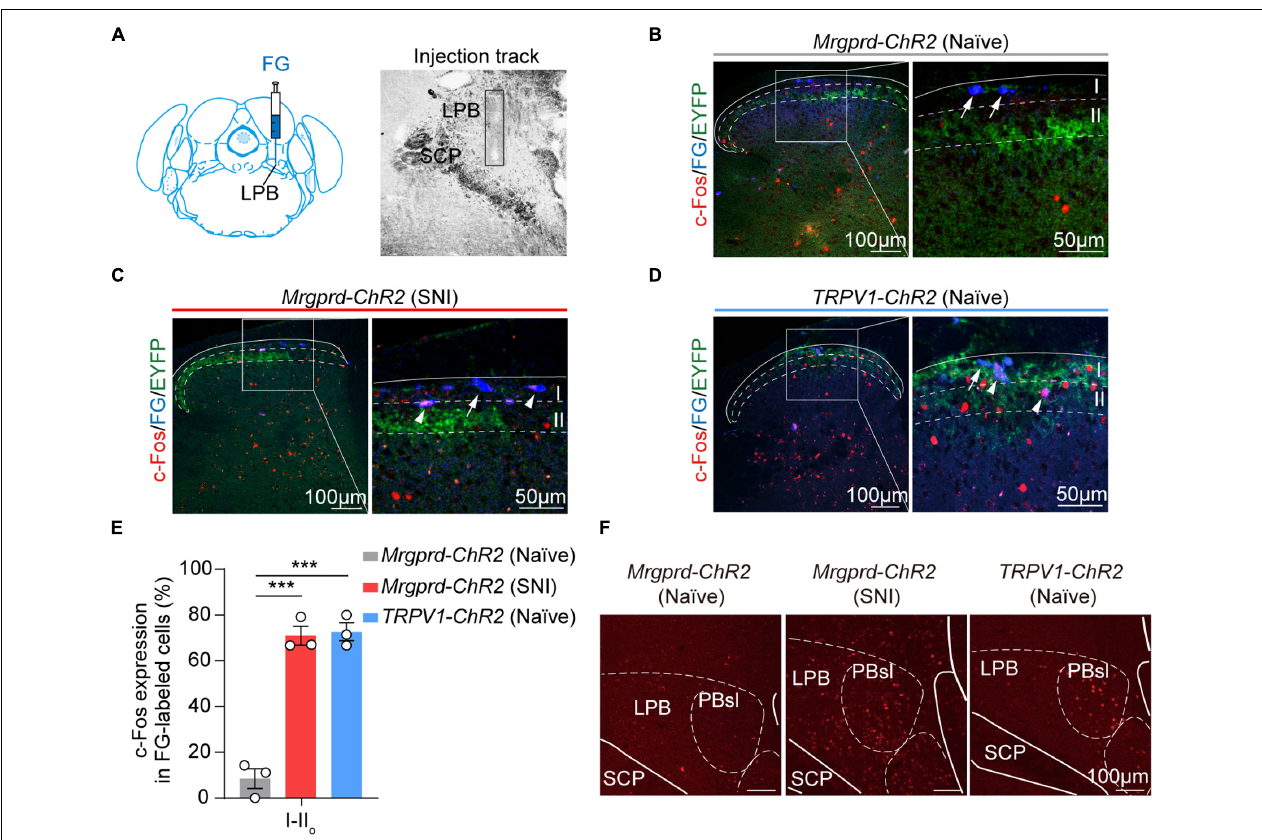
FIGURE 6 | Optogenetic activation of cutaneous Mrgprd + fibers induces c-Fos expression on superficial spinal cord-lPBN projection neurons under neuropathic pain conditions. (A) Schematic of Fluoro-gold injection site (left) and image of injection track within lPBN (right) (contralateral lPBN to SNI). (B–D) Representative images of colocalization of c-Fos + neurons (red) with FG-labeled superficial lPBN-projection neurons (blue) in naïve Mrgprd-ChR2 mice (B) , SNI Mrgprd-ChR2 mice (C) , and naïve TRPV1-ChR2 mice (D) . The arrow indicates FG + -labeled cells without c-Fos expression, and the arrowhead indicates double labeled (FG + and c-Fos + ) cells. (E) Statistical data for the percent of c-Fos + neurons in FG-labeled cells (c-Fos + FG + /FG + ) in lamina I–II o of the spinal dorsal horn induced by blue light in naïve Mrgprd-ChR2 mice, SNI Mrgprd-ChR2 mice and naïve TRPV1-ChR2 mice ( n = 3 animals per group). (F) Representative images of c-Fos (red) expression in lPBN evoked by hindpaw blue light stimulation in naïve Mrgprd-ChR2 mice, SNI Mrgprd-ChR2 mice and naïve TRPV1-ChR2 mice. Data are presented as mean ± SEM. *** p < 0.001. One-way repeated-measures ANOVA with holm-sidak test for (E) . Scale bar, 100 µ m (50 µ m for high